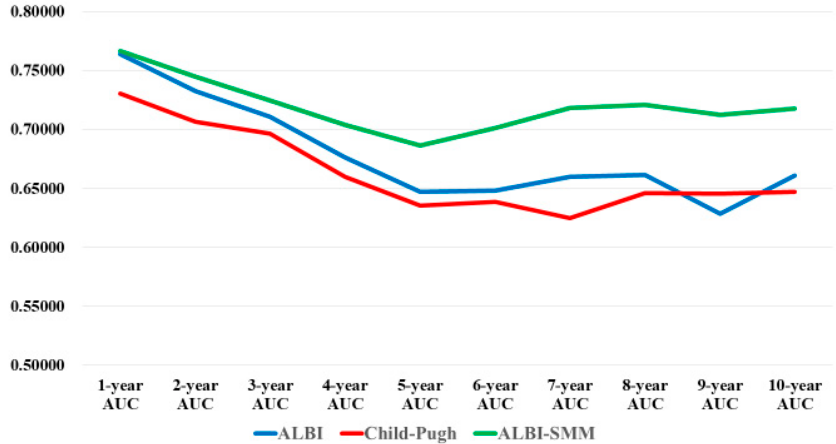
Figure 8. Area under the receiver operating characteristic curves (AUCs) in time-dependent ROC analysis in the ALBI grade, the Child-Pugh classification and the ALBI-SMM grade in each time point.